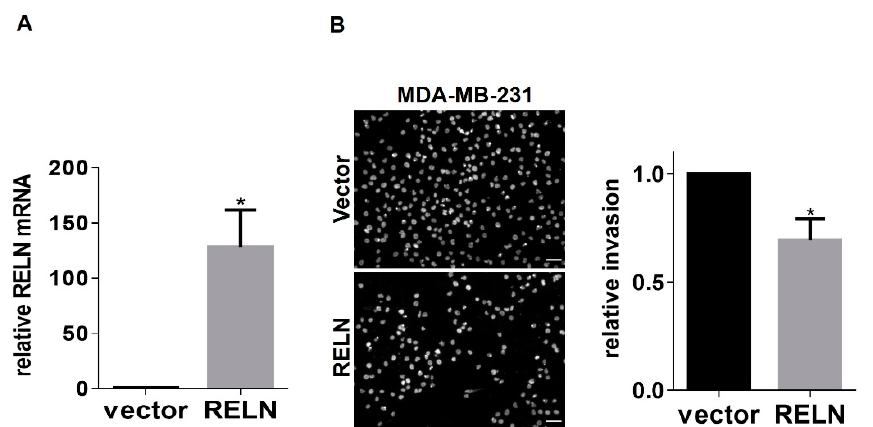
Figure 6. RELN overexpression inhibits invasion of MDA-MB-231 cells. ( A ) qRT-PCR was performed to compare RELN mRNA in MDA-MB-231 cells that overexpress RELN; control, pcDNA3.1 vector. ( B ) Invasive potential of MDA-MB-231 cells transfected with vector or overexpressing RELN was compared using Matrigel invasion assays. Images show representative fields of DAPI-stained cells that had invaded to the undersides of transwell filters; scale bar, 100 µ M. Graph shows relative cell invasion. Data are average +/ − SEM, n = 3; * p ≤ 0.05, unpaired t -test.